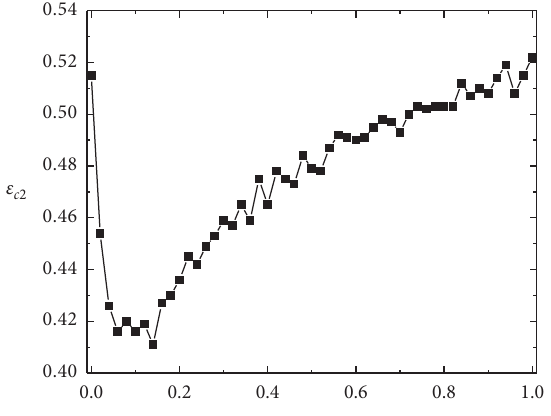
Figure 3: The critical bounded confidence ε c 2 , over which the system can always reach complete consensus, as a function of α . 1.0